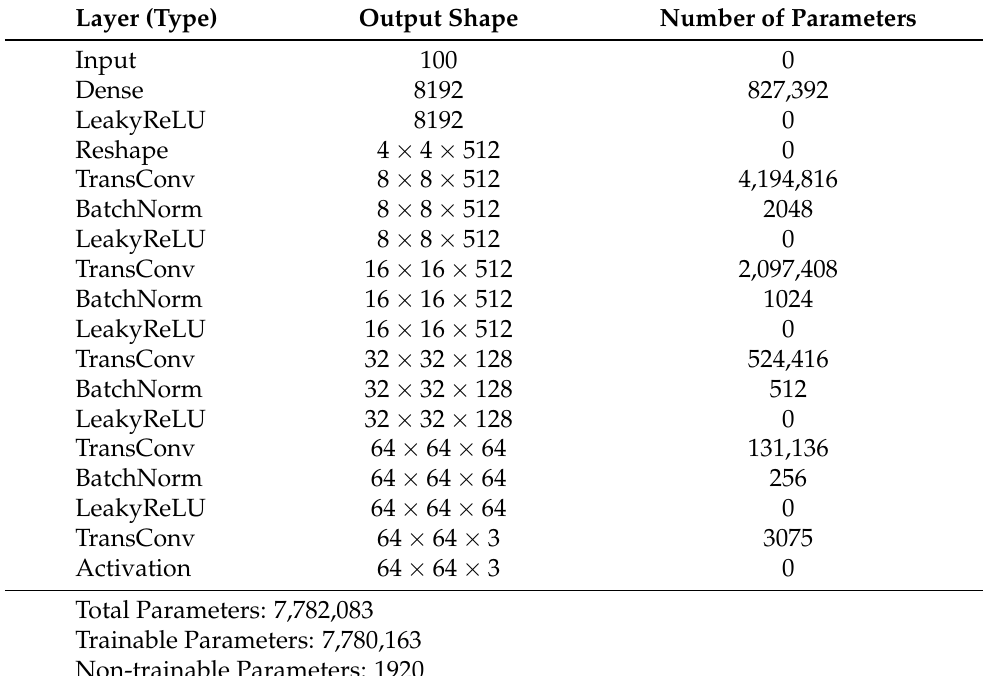
Table 2. The architecture of the generator.